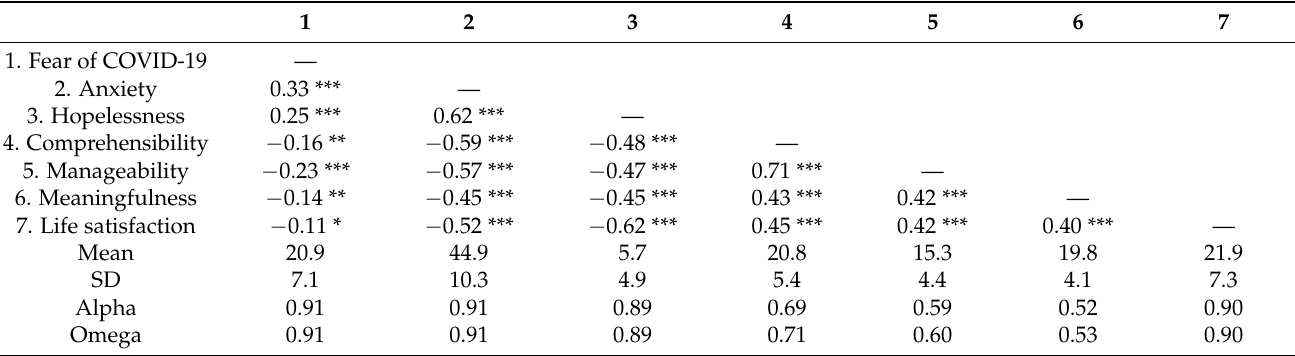
Table 1. Descriptive statistics, intercorrelations, and reliabilities of study